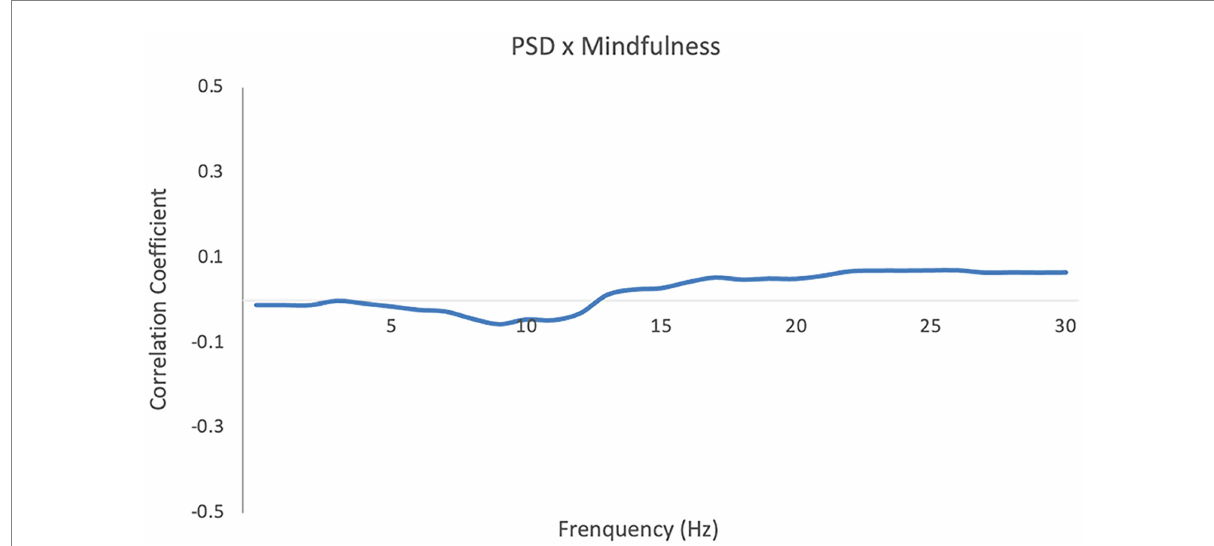
FIGURE 1 Pearson correlation coefficient between individuals’ MAAS score and their power spectral density (PSD). Cluster-based permutation analysis of the correlation coefficients showed no significant clusters ( p =